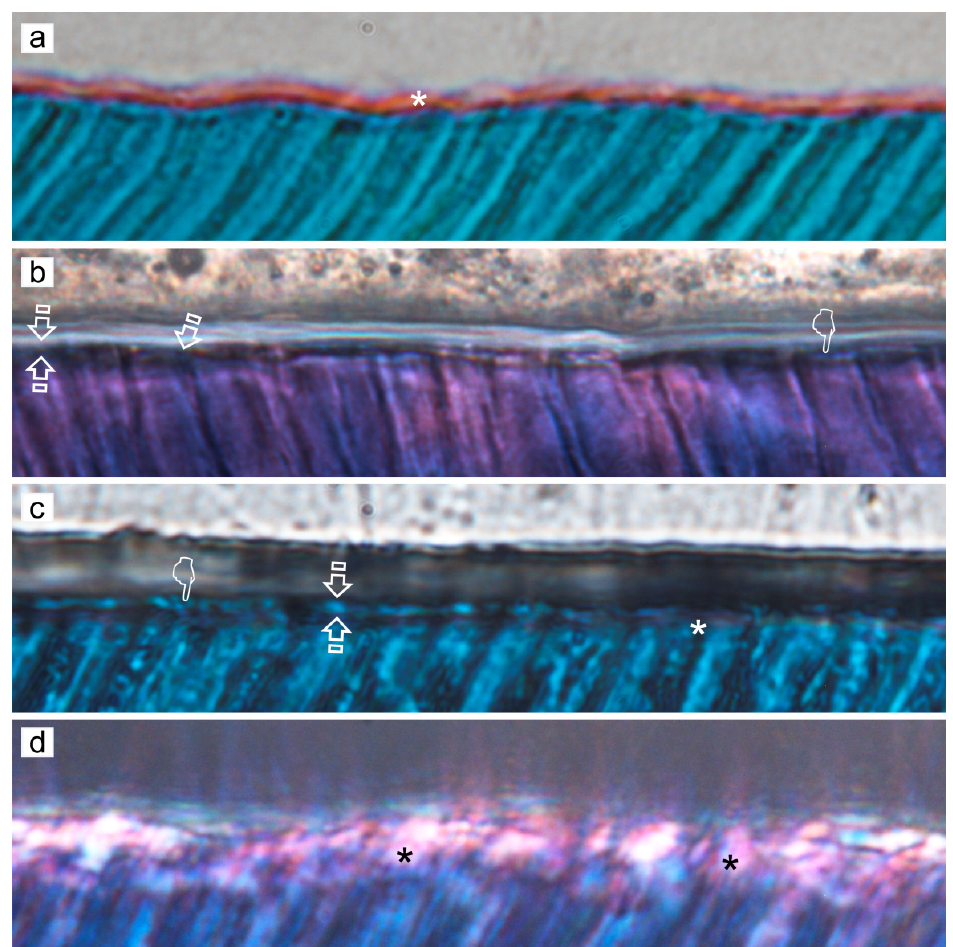
Figure 5. Representative light micrographs of SEB adhesive systems in sound dentin specimens; interfaces stained with Masson’s trichrome: mineralized dentin stained green, adhesive stained beige, and exposed protein stained red. Original magnification: 150 × . ( a ) SEB control. ( b ) SEB.P-ZnO. ( c ) SEB.P-ZnCl 2 . ( d ) SEB.Bd-ZnO. Limited and clear resin uncovered decalcified dentin is shown (asterisk) ( a ). Evidence of partial demineralization or exposed protein may be detectable at the resin–dentin interface and tubular area (asterisks) ( c ). Slight and faint signs of demineralization show the scarce exposed proteins detected (arrows) ( b ). No signs of demineralization or exposed protein (red stain) are detectable at the resin–dentin interface when the primer was ZnO or ZnCl 2 doped; clear observation of histological remineralization of the partially demineralized dentin layer is shown (pointer) ( b ). Absence of unprotected collagen layer is observable in some specimens (faced arrows) ( c ). Abbreviations: SEB, SE-Bond; SEB.P, SE-Bond primer; SEB.Bd, SE-Bond bonding; ZnO, zinc oxide; ZnCl 2 , zinc